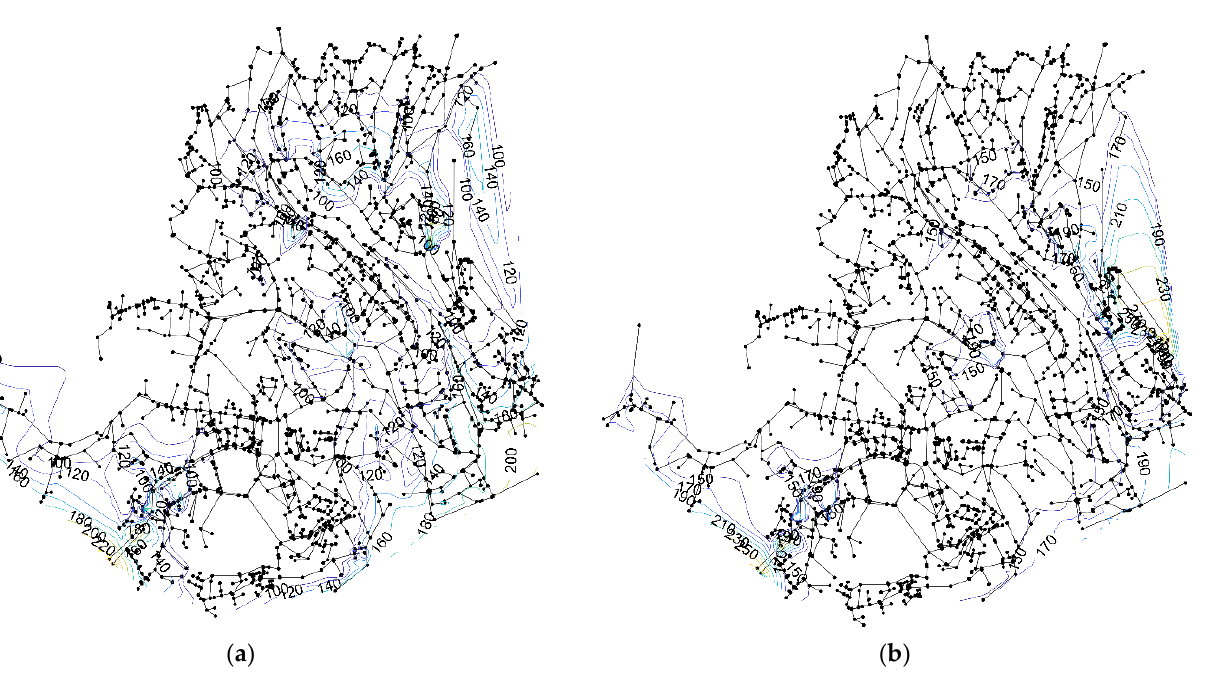
Figure 15. Pressure contour plot when devices are installed ( a ) and without performing any pressure control strategy ( b ) for case (I).